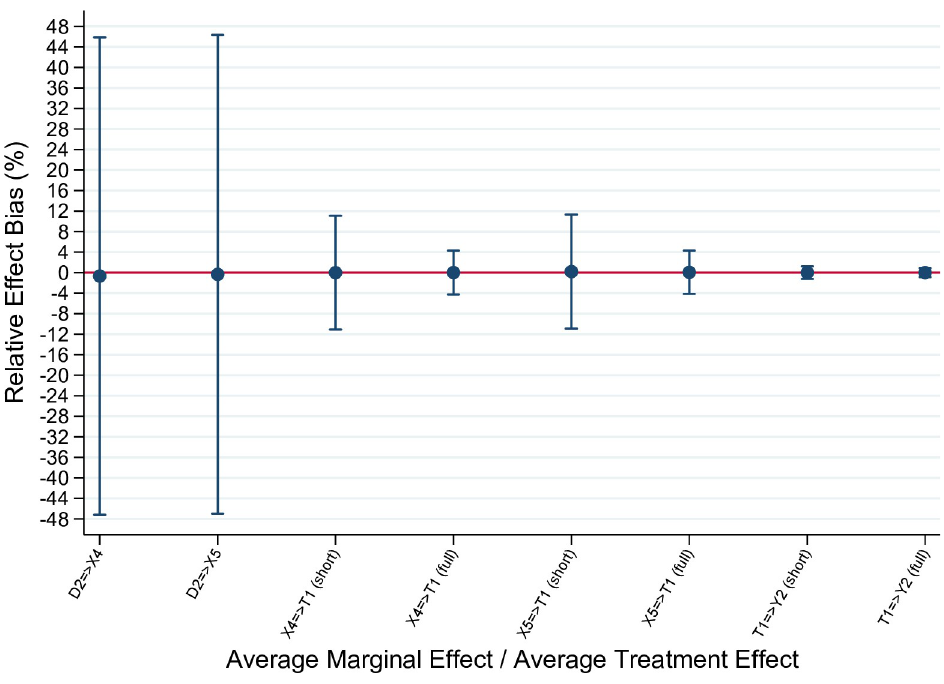
Fig 5. Results from Monte Carlo simulations–Relative effect